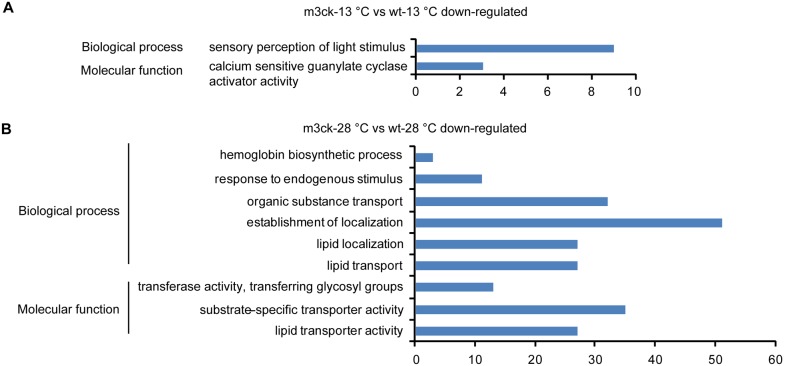
GO enrichment analysis of down-regulated transcripts between transgenic and wild-type fish under cold stress or normal temperature.A. m3ck-28°C vs. wt-28°C down-regulated transcripts. B. m3ck-13°C vs. wt-13°C down-regulated transcripts. The horizontal axis represents transcript count in each GO term. Up- and down-regulated transcripts were submitted for GO enrichment analysis using the SAS online analysis system.